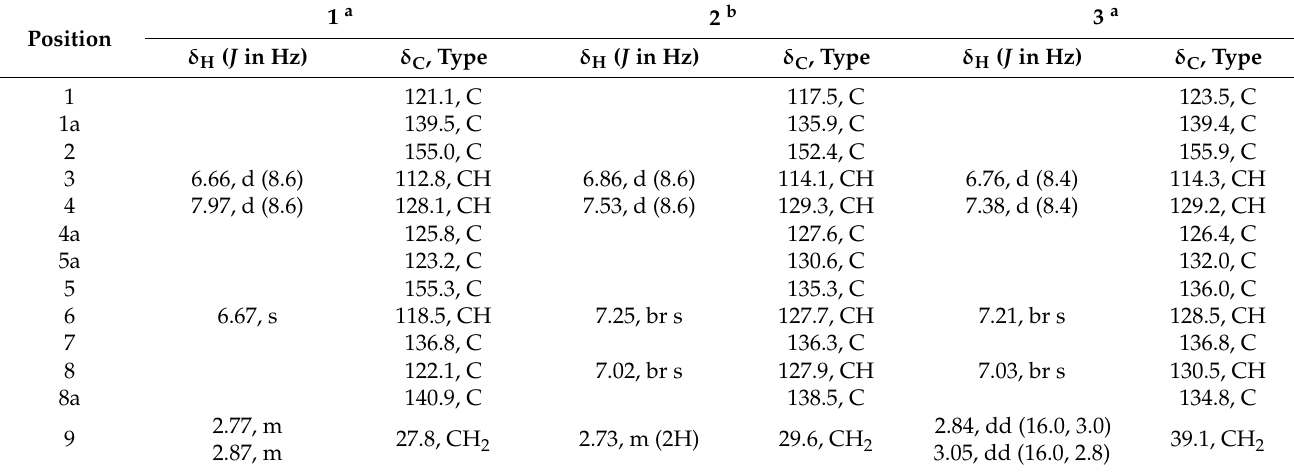
Table 1. 1 H (500 MHz) and 13 C (125 MHz) NMR data of compounds 1 – 3